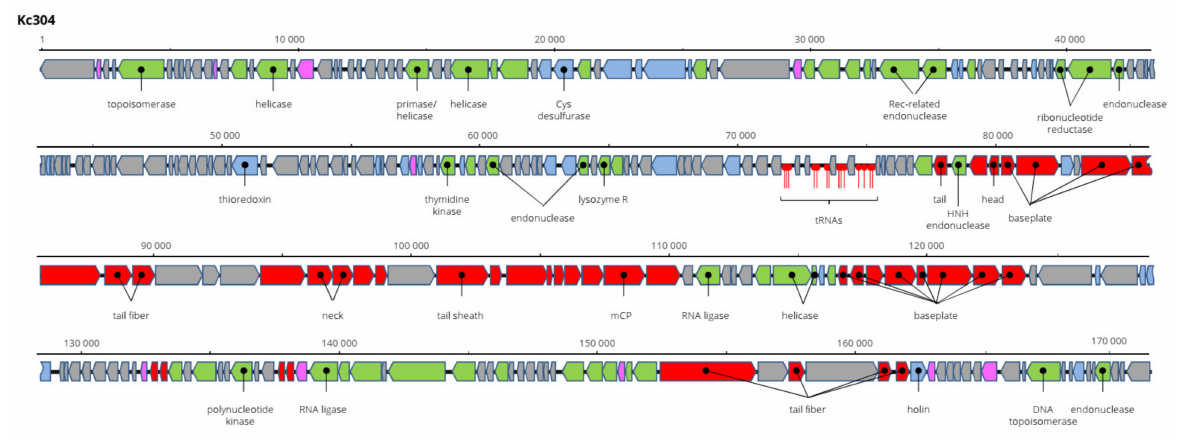
Figure 8. Genome structure and annotation of the Kc304